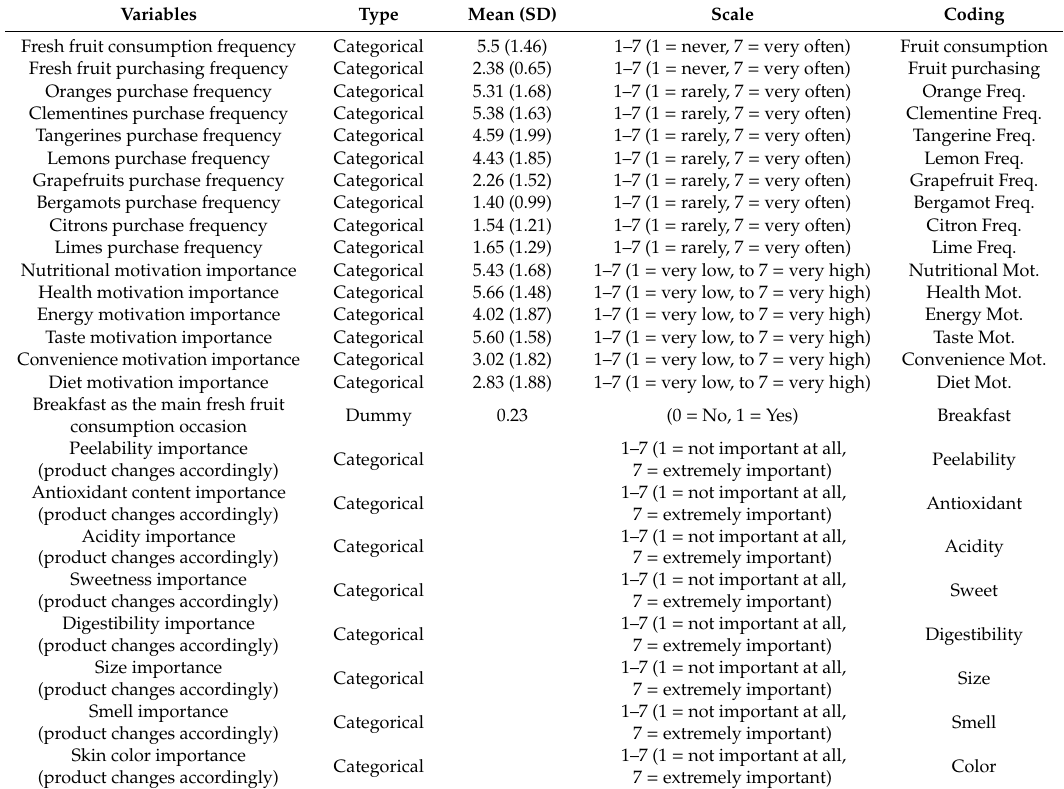
Table 2. List and type of variables collected in the